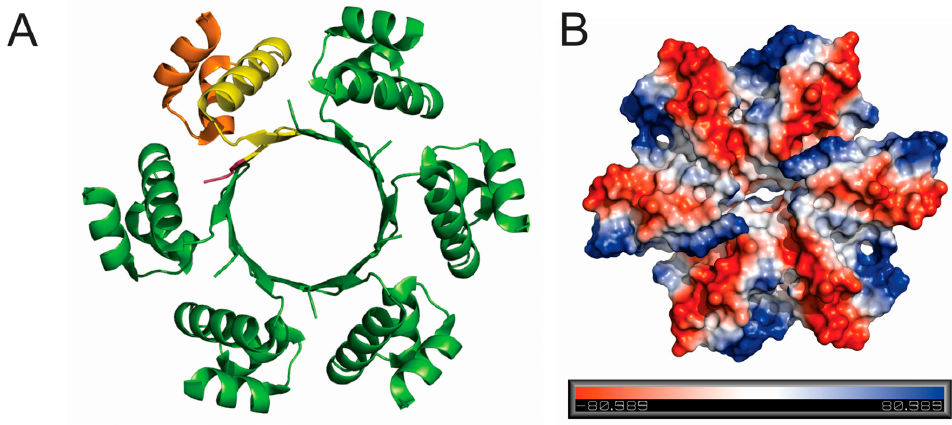
Figure 5. Crystal structure of SIRV1_Gp1. ( A ) Hexameric conformation in which the protein was crystallized. One individual subunit is depicted in yellow. The HTH domain is highlighted in orange and the N ‐ terminus is shown in purple. ( B ) Surface representation showing electrostatic potential.